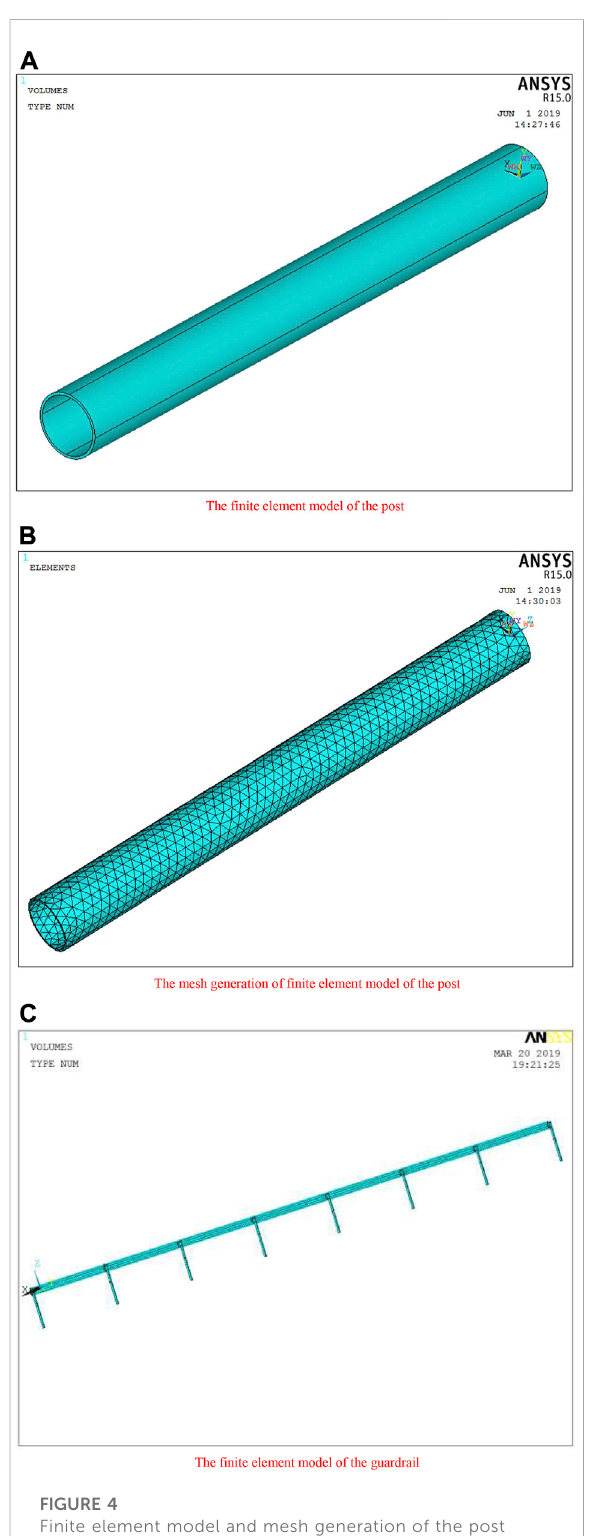
FIGURE 4 Finite element model and mesh generation of the post and the guardrail. (A) : Finite element model of the post; (B) : The mesh generation of fi nite element model; (C) : Finite element